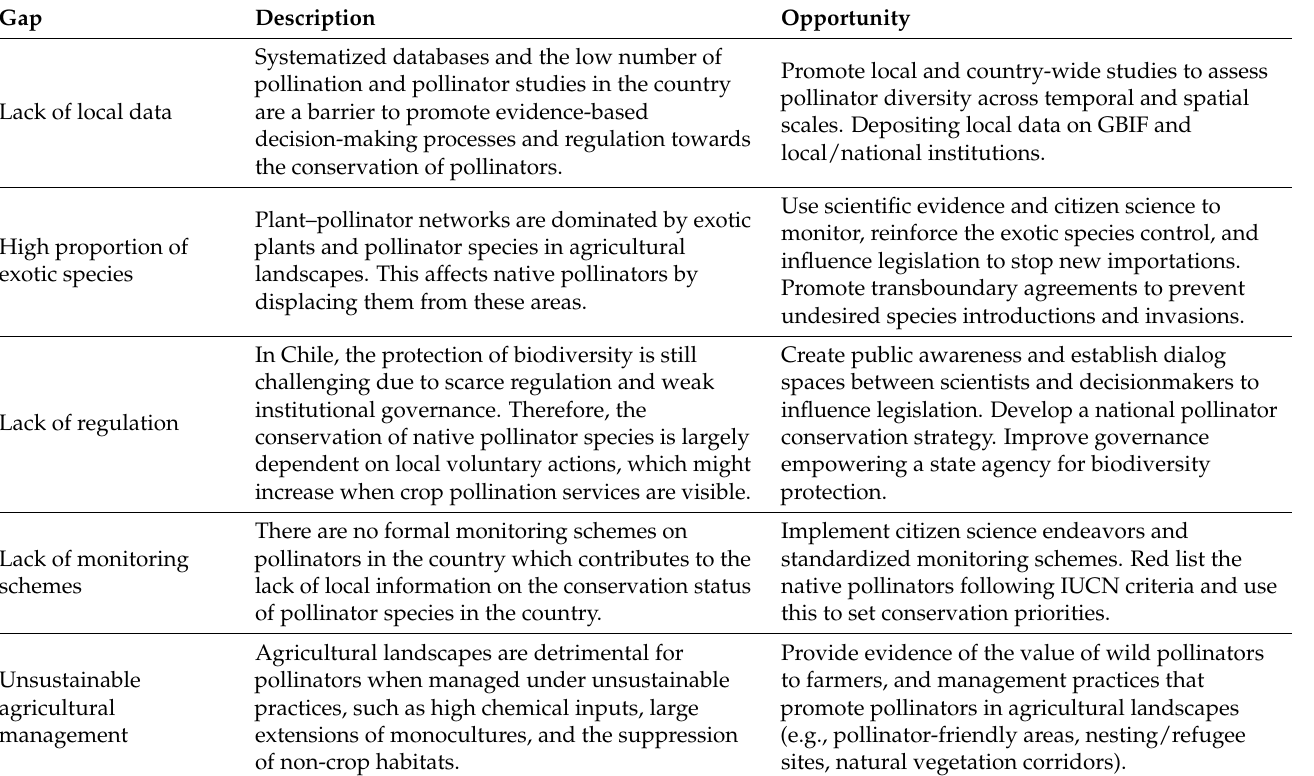
Table 1. Summary of key knowledge gaps, their descriptions, and